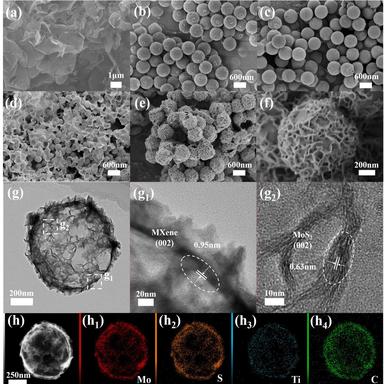
SEM images of (a) FL-MXene, (b) PS sphere, (c) MXene@PS, (d) HMXene, (e) and (f) MoS2@MXene-20, (g-g2); TEM images of MoS2@MXene-20 composite at different magnifications, and (h-h4) Distribution of Mo, S, Ti and C elements of MoS2@MXene-20 composite.